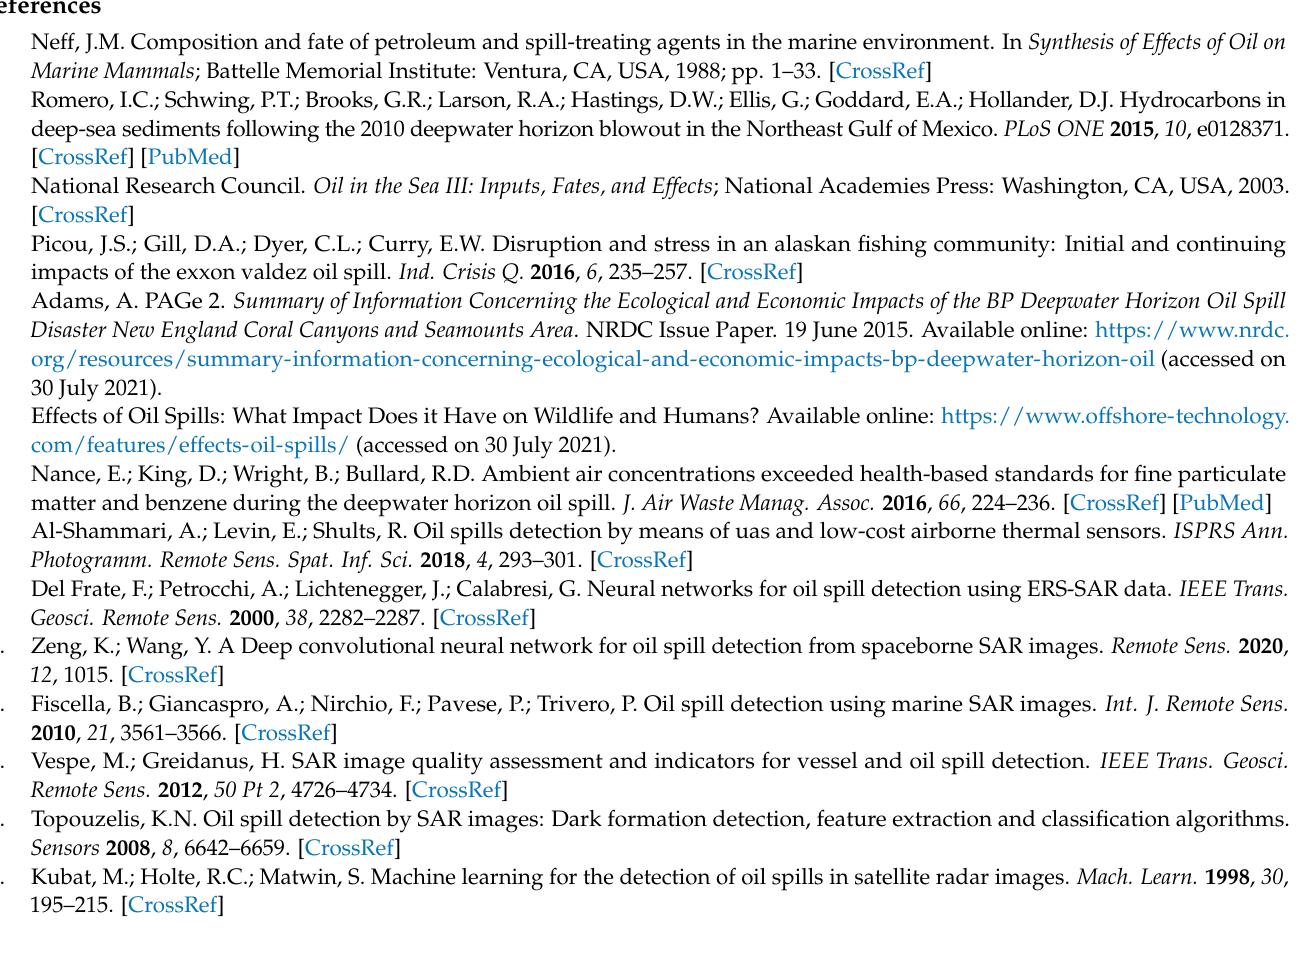
Table S2: OS-Net performance under different data augmentation methods. Table S3: OS-Net hyper- parameters tuning grid search values. Figure S1: VOS-Net prediction results. The X axis shows the prediction index with time (1 prediction/s) and the Y axis shows the VOS-Net prediction result. The black line represents the region where there was oil sheen present. Ground truth labels are shown at the top of each